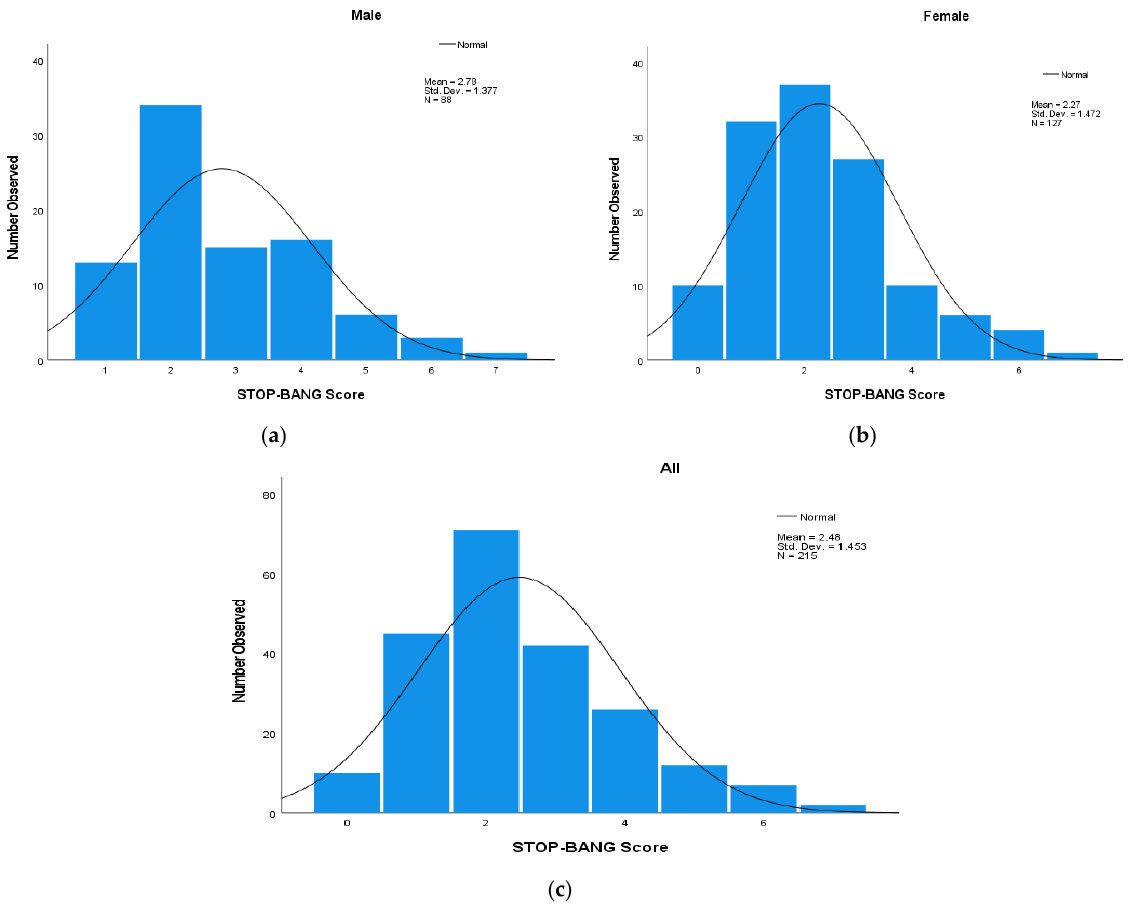
Figure 1. Distribution of the STOP-Bang summary scores. ( a ) Distribution of the STOP-Bang summary scores for males. ( b ) Distribution of the STOP-Bang summary scores for females. ( c ) Distribution of the STOP-Bang summary scores for all.